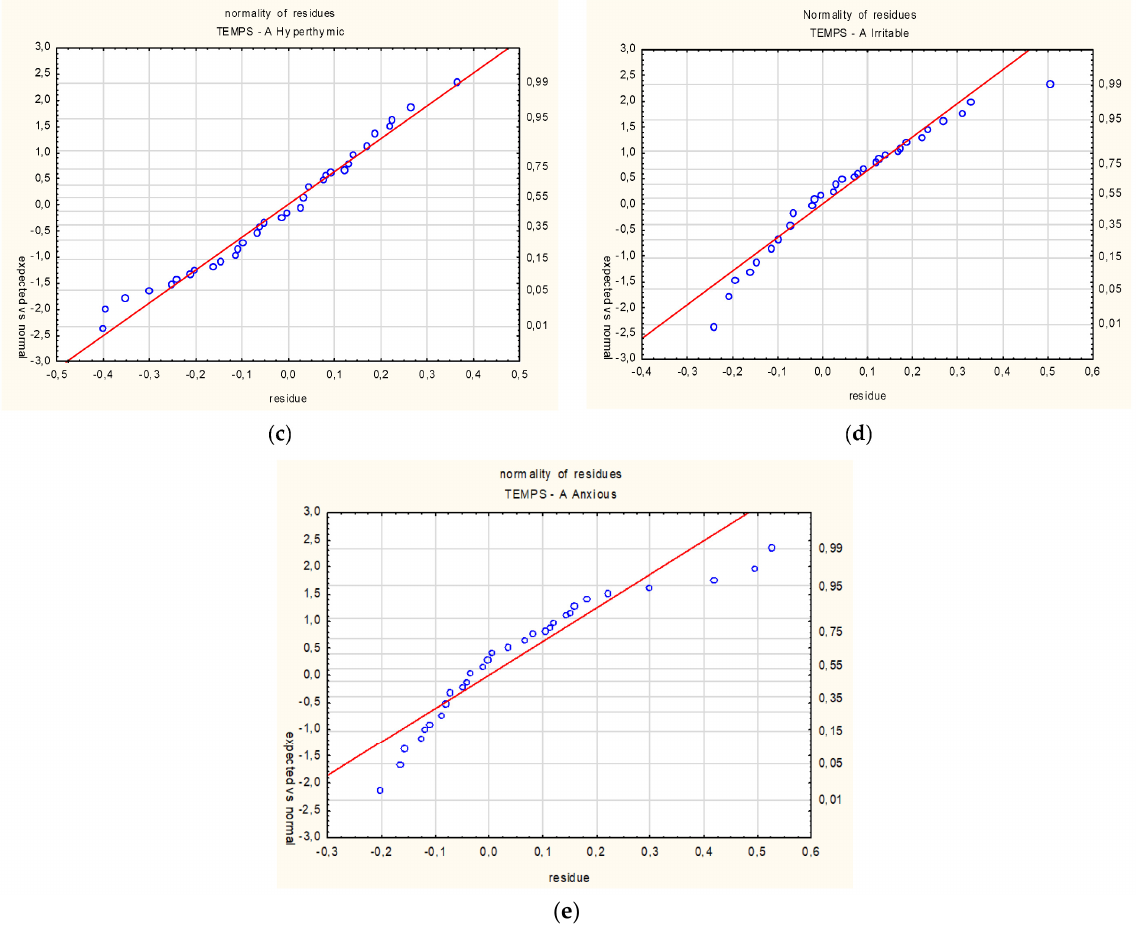
Figure 2. The diagram of normality of residues of affective temperaments dimensions: ( a ) depressive, ( b ) cyclothymic, ( c ) hyperthymic, ( d ) irritable and ( e ) anxious.